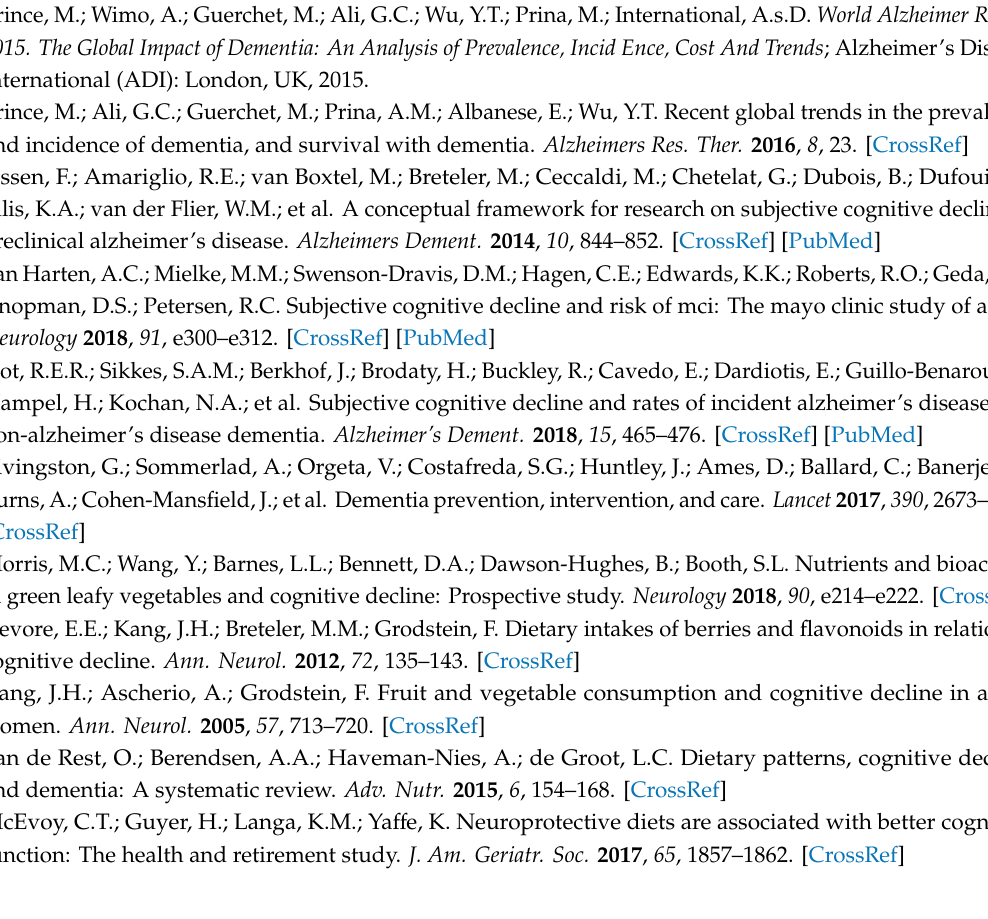
Table S1: Dutch guidelines for a Healthy Diet, Table S2: Cluster centers based on PCA